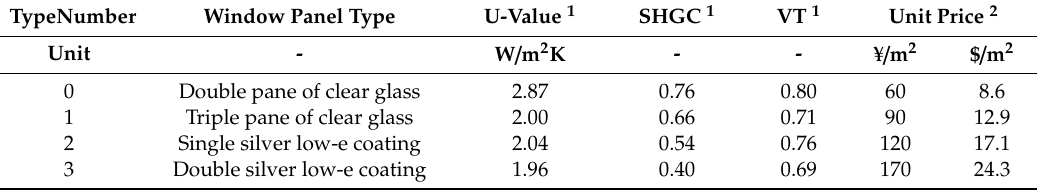
Table 3. Thermal, optical and price properties of di ff erent window panel